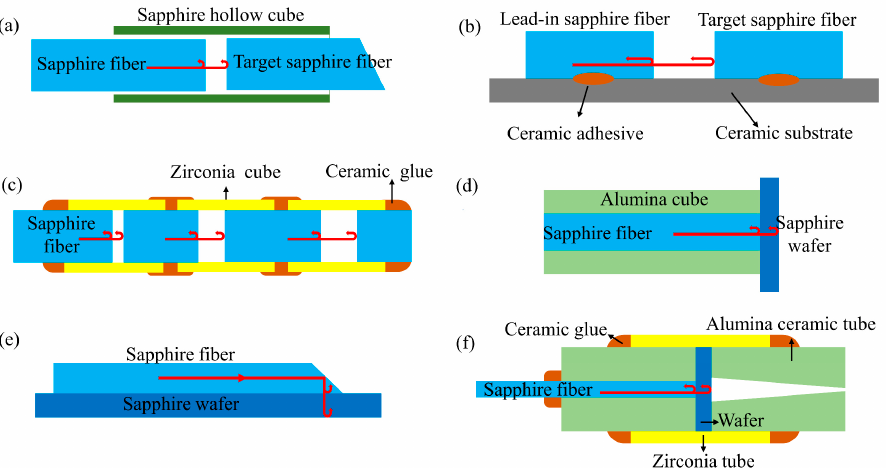
Figure 8. Configuration of various types of Sapphire FPIs. ( a ) Air cavity EFPI formed by two sections of sapphire fiber [106]; ( b ) EFPI formed by fixing two sapphire fibers on a ceramic base; ( c ) Multiplexed high-temperature sensor by concatenating multiple air-gap sapphire FPIs; ( d ) FPI formed by bonding a section of sapphire fiber with a sapphire wafer end-to-end; ( e ) Sapphire wafer is flush-mounted to sapphire fiber to form FPI; ( f ) EFPI with high-temperature resistant package.